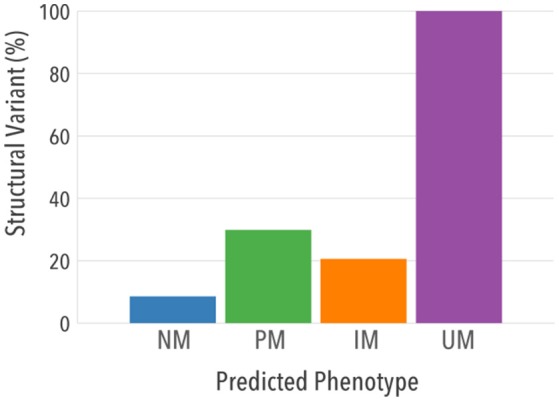
Contribution of structural variants and single copy variants to predicted phenotypes. Proportion of individuals in each predicted phenotype that had at least one structural variant is shown.